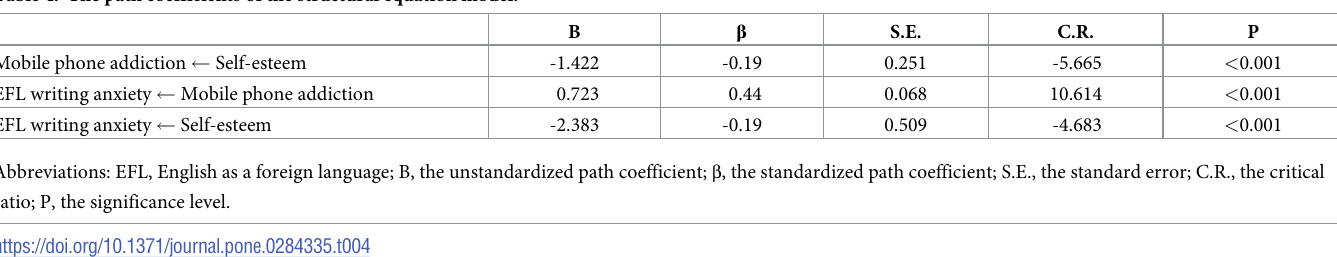
Table 4. The path coefficients of the structural equation